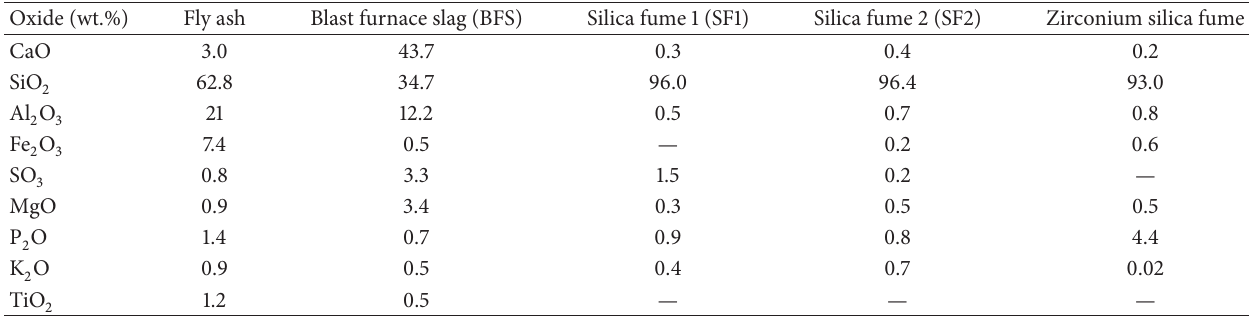
Table 1: Chemical composition of the binder